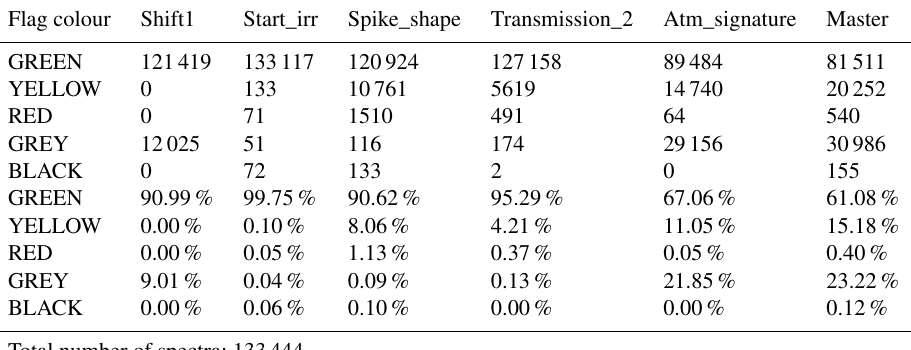
Table 5. Absolute and relative frequencies of different flag colours given by the QA tools of the European UV DataBase (EUVDB) for the UV irradiance spectra measured by the Sodankylä Brewer #037 over the years 1990–2014. Flag colour Shift1 Start_irr Spike_shape